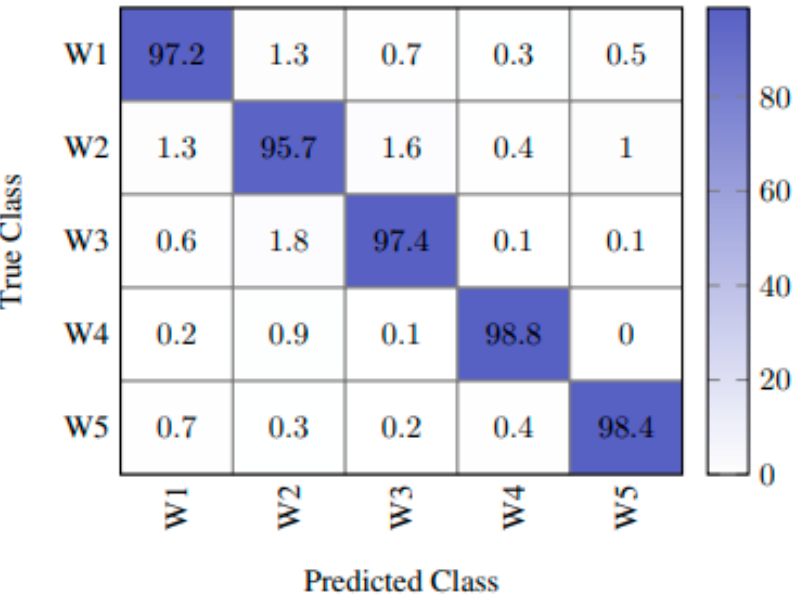
Figure 23. Confusion matrix for five different human activities.